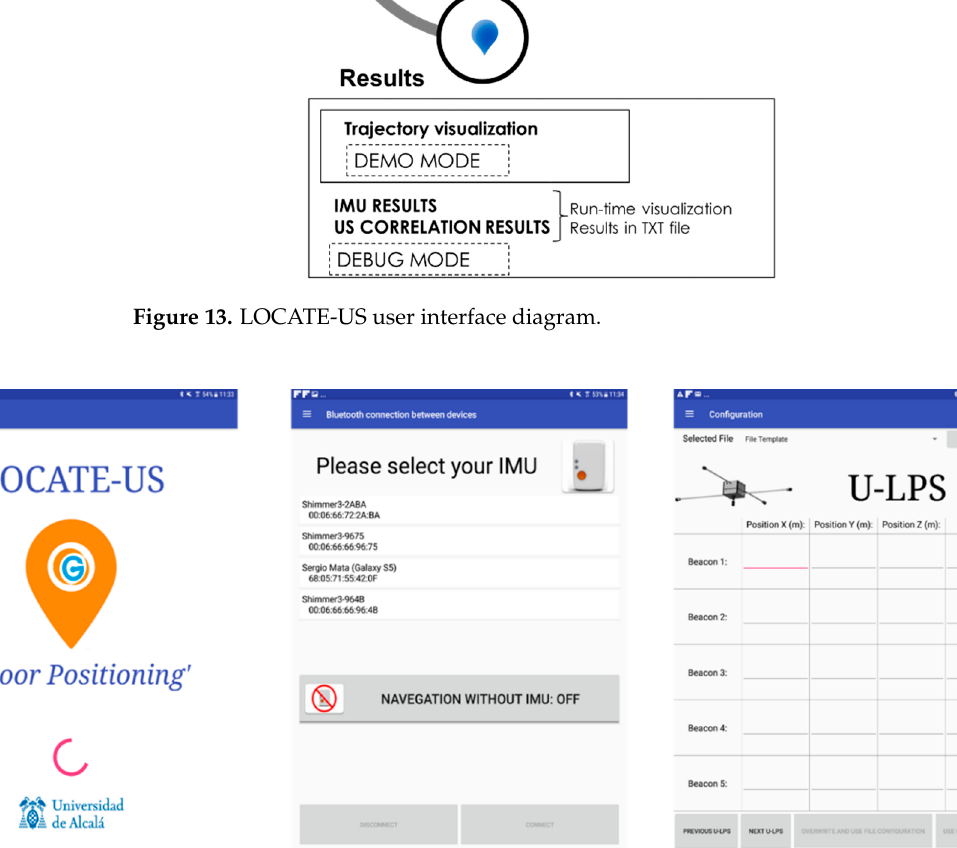
Figure 15. Example of plain text file for U-LPS configuration.